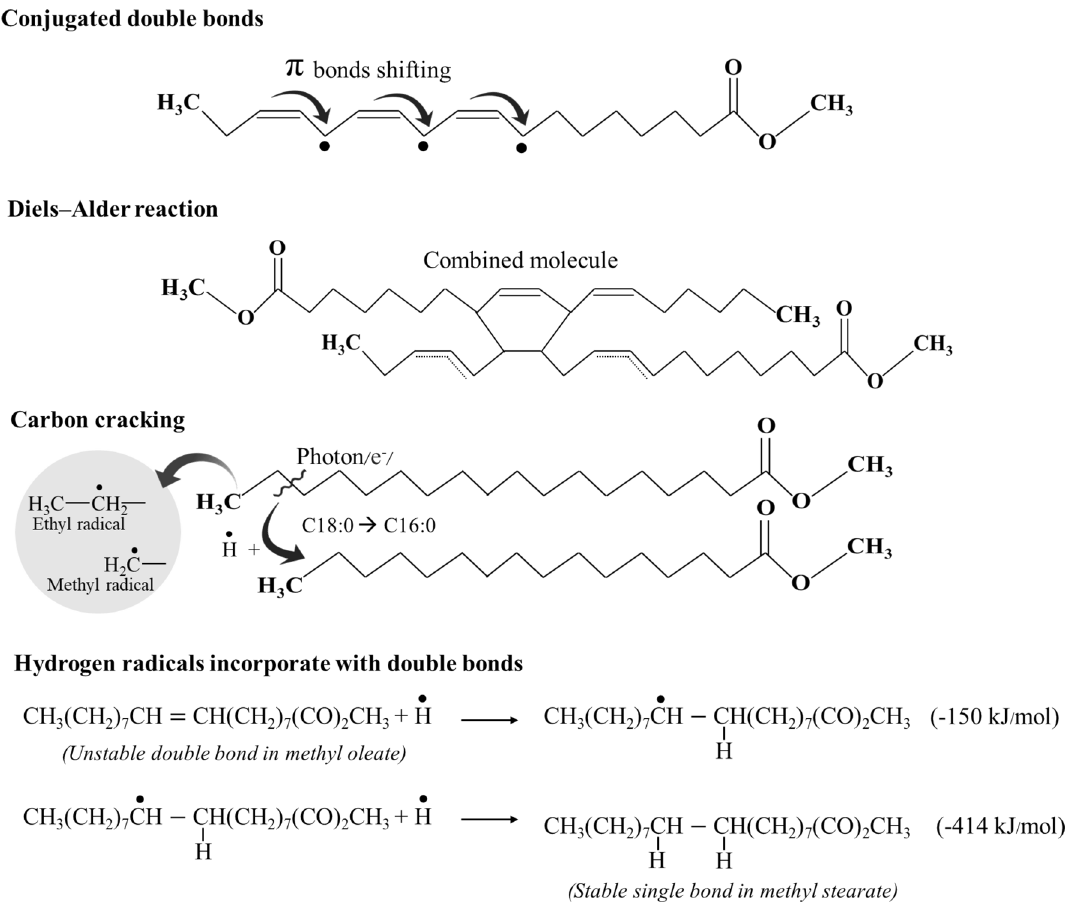
Figure 7. Plasma chemical mechanism for FAME hydrogenation (drawn using Microsoft PowerPoint version 2104, https:// www. micro soft. com/ th- th/ micro soft- 365/ power